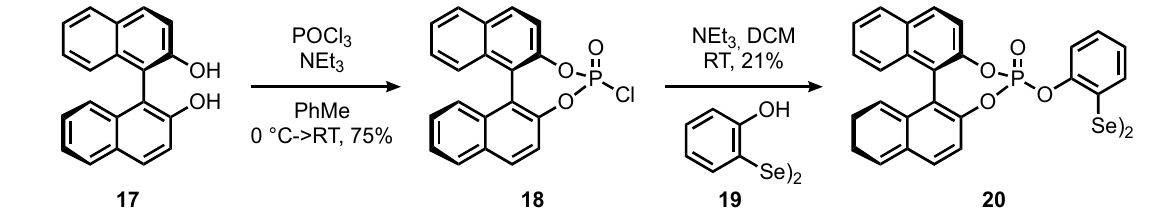
Scheme 5. The synthetic route toward chiral, non-racemic diselenide 20 Scheme 5: The synthetic route toward chiral, non-racemic diselenide 20.